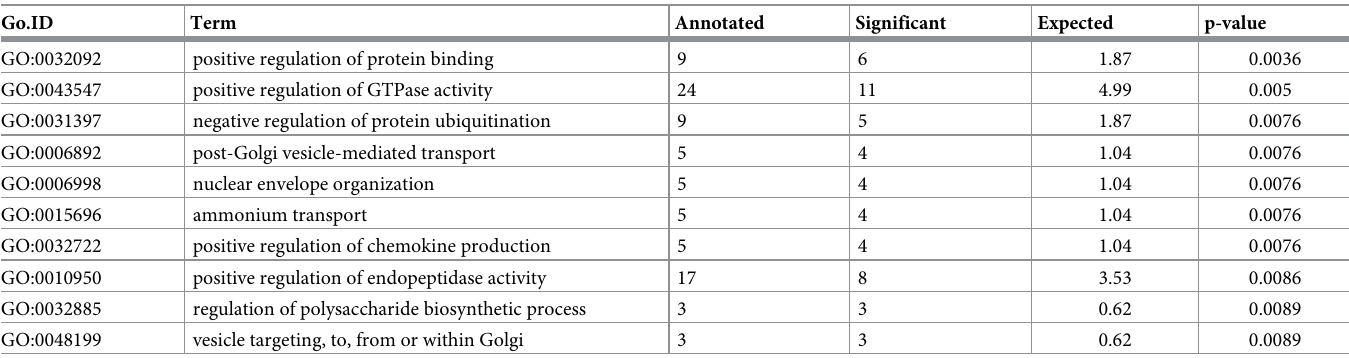
Table 4. Top 10 enriched GO